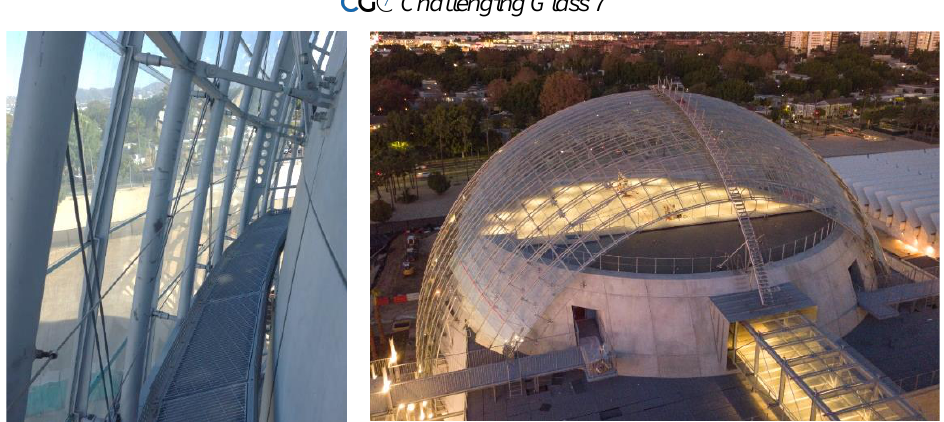
Figs. 16, 17 Maintenance catwalk on the east side of the dome (left, similar on west side), and maintenance stair for a secured approach of the dome apex from the south side of the dome (right), both images are during construction (Images: Knippers Helbig, Patrick Price).